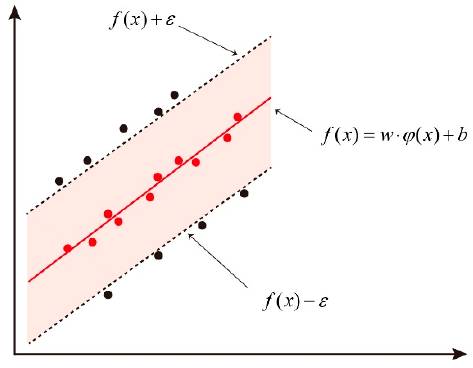
Figure 1. SVR model diagram.